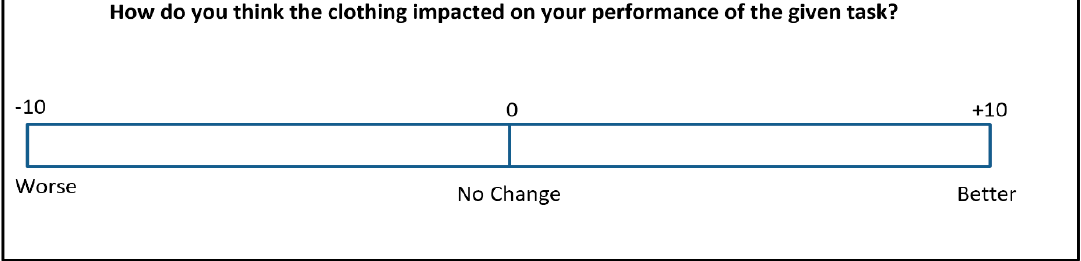
Figure 3. Mannequin sketch to mark any areas of discomfort. 2.10. Data Analysis All data were entered into a Microsoft Excel data spreadsheet before being transferred into SPSS for analyses (Version 26, IBM, 2018). Demographic data and the performance measure scores for each type of tasks and clothing variants were initially analyzed descriptively to derive means and standard deviations and data was explored. Inferential analyses were then conducted using a Repeated Measures Analysis of Variance (ANOVA) to detect significant differences in performance measures across the clothing variants. If a significant difference was found, a post-hoc pairwise comparison with Bonferroni adjustment was performed to detect where the differences lay. For comparing individual FMS task scores associated with each type of clothing, a Wilcoxon signed rank analysis was performed, consistent with the ordinal nature of the data. The overall level of significance was set a priori at α = 0.05. 3. Results